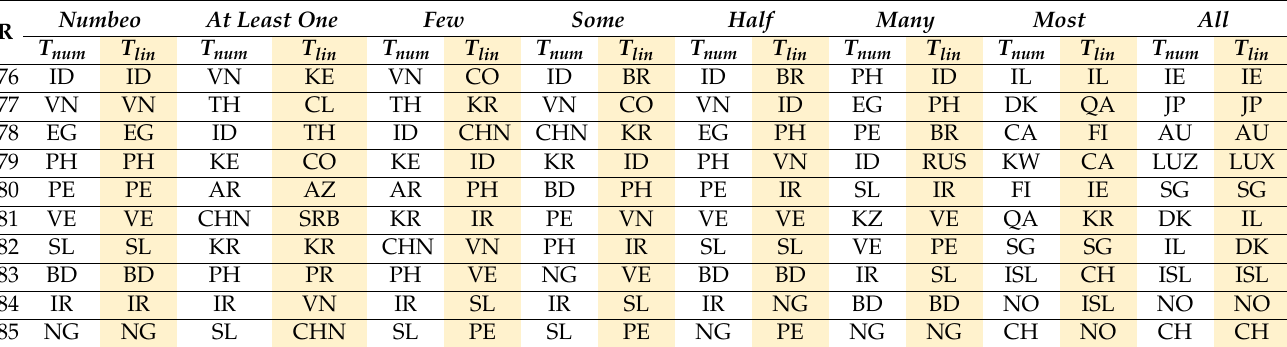
Table 11. Re-ranked QOLI of worst 10 countries (number versus. 2-tuple